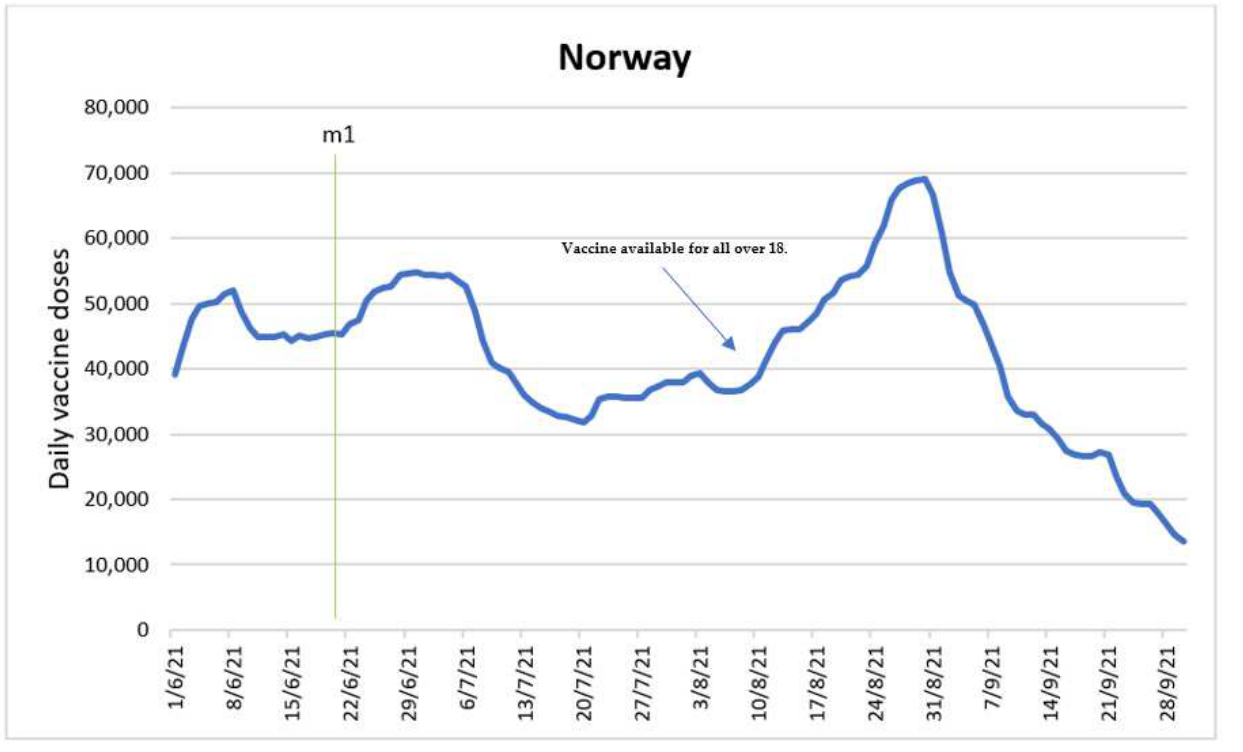
Figure 1. Daily new vaccinations in Austria before and after the policy changes and predicted values Figure 4. Daily new vaccinations in Norway before and after the policy change. Figure 4. Daily new vaccinations in Norway before and after the policy change. in absence of intervention based on ARIMA